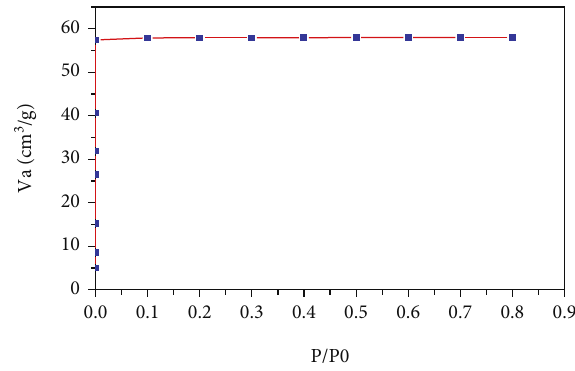
Figure 8: Nitrogen adsorption at -196 ° C on the activated carbon fi ber prepared at optimal